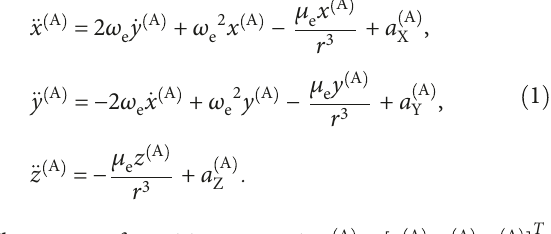
Figure 1: Displaced GEO in the rotating reference frame